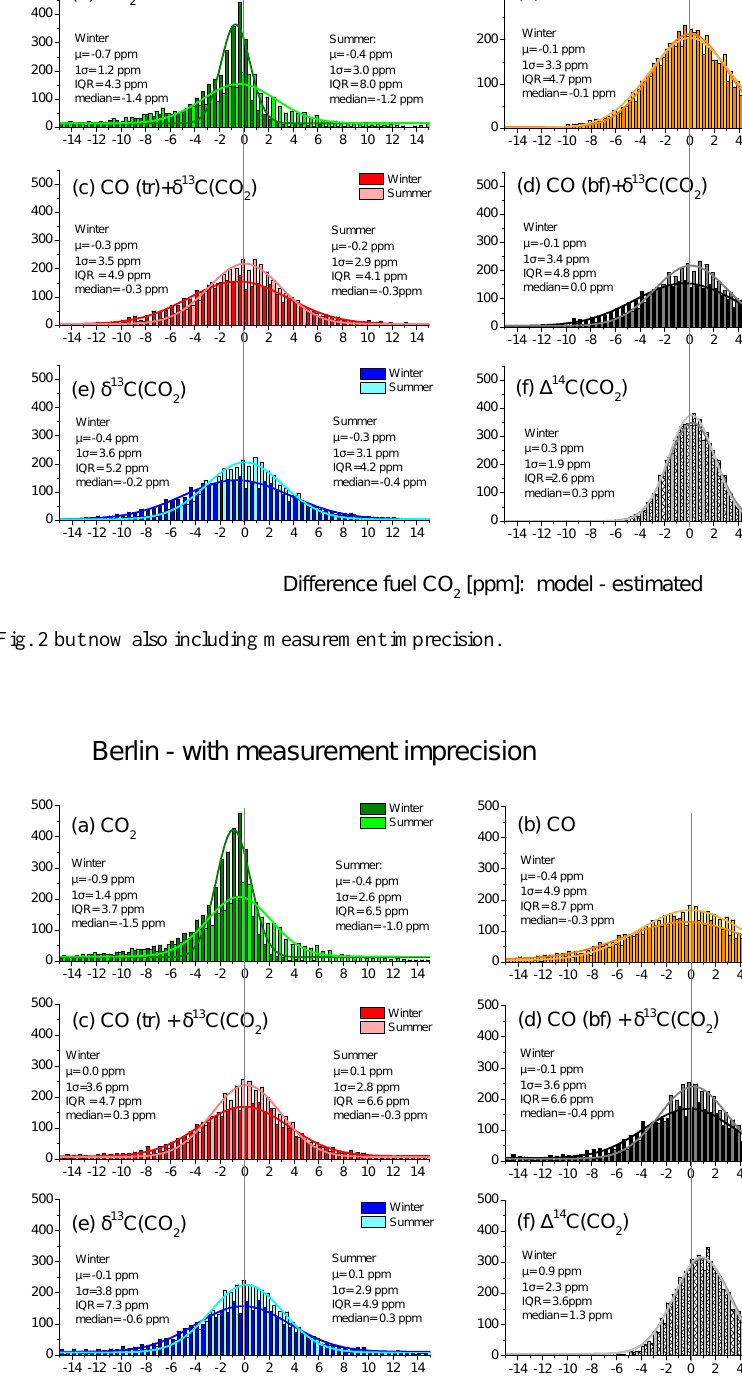
Figure 7. Same as Fig. 3 but now also including measurement